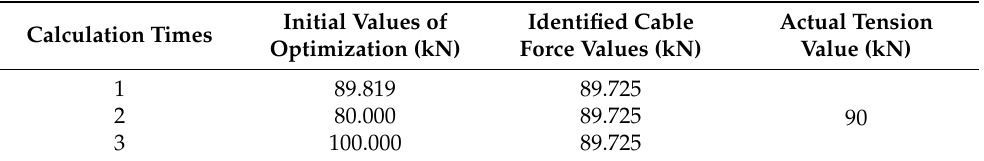
Figure 11. Self-spectral analysis of the acceleration response. Table 2. Results of frequency detection and cable force identification.